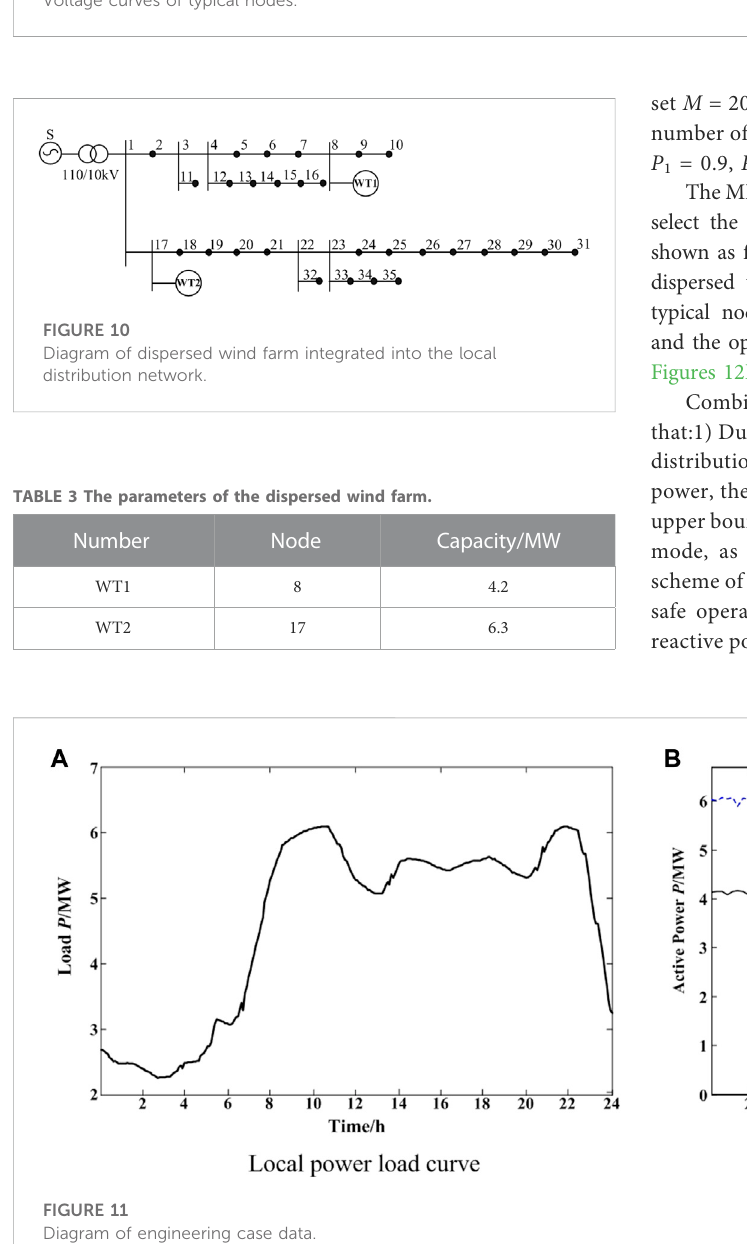
FIGURE 9 Voltage curves of typical nodes.